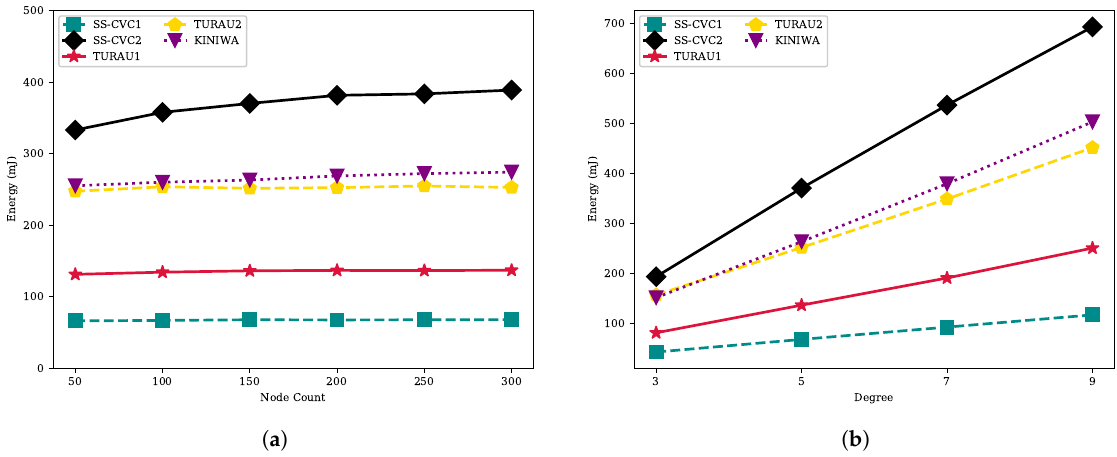
Figure 11. Energy consumption of algorithms on weighted networks: ( a ) Energy consumption against node count on the fixed average degree 5; ( b ) Energy consumption against node count on the fixed network size